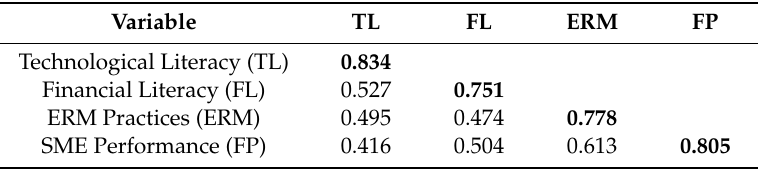
Table 4. Discriminant validity—Fornell and Larcker criterion.